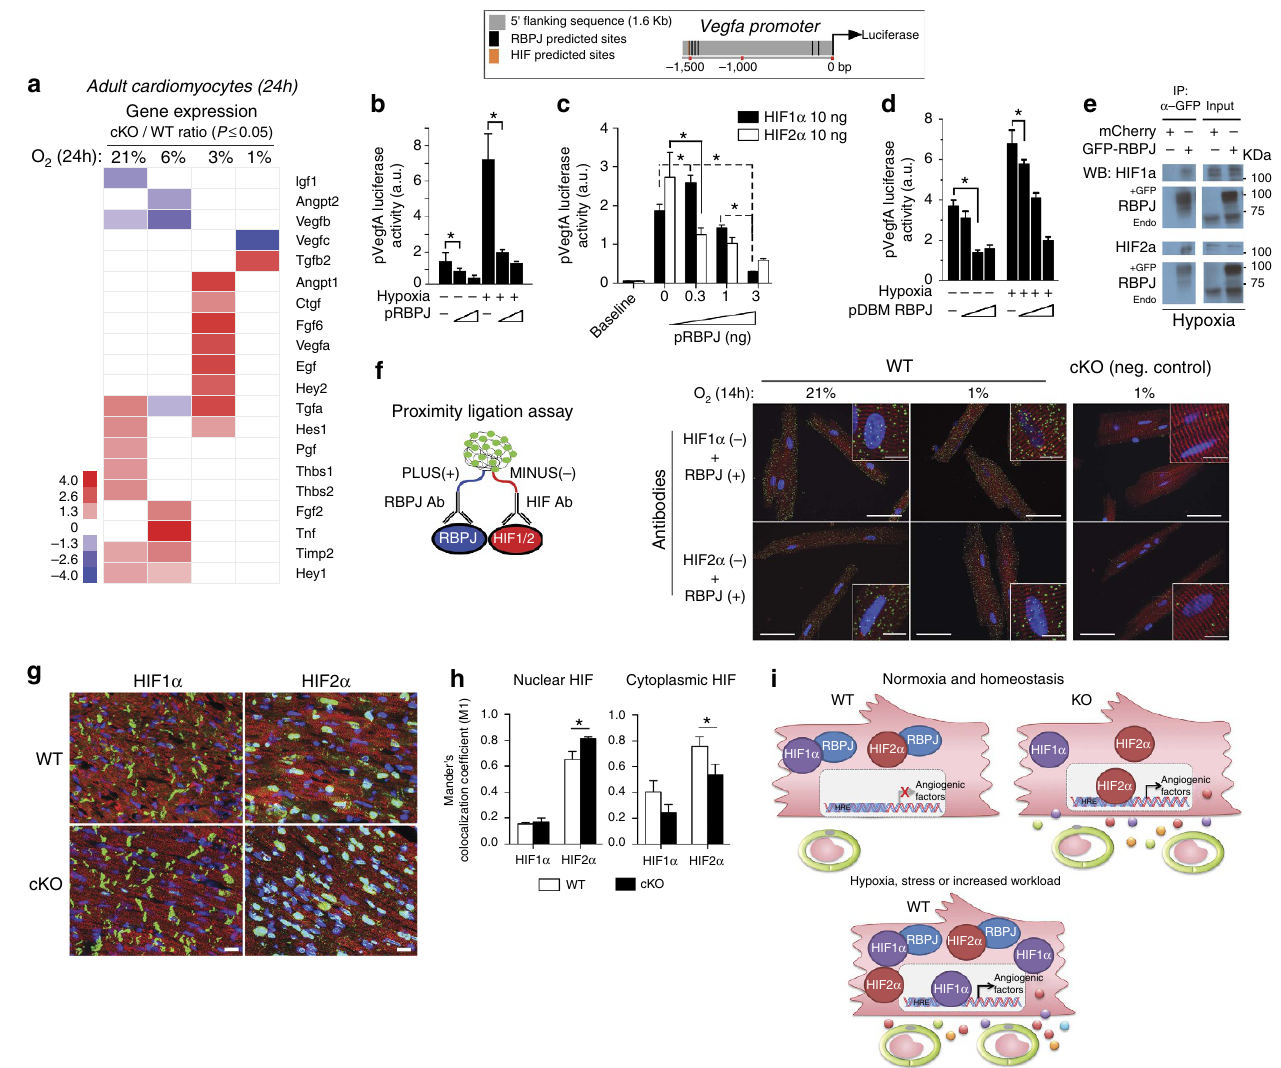
Figure 4 | RBPJ suppresses myocardial angiogenesis by antagonizing HIFs. ( a ) The heatmap represents the ratio of cKO to WT gene expression for statistically significantly induced (red) or repressed (blue) genes (Mann–Whitney, n ¼ 4, P r 0.05; see Methods section) in isolated cardiomyocytes cultured for 24h at the indicated O 2 levels. White indicates no differences. Inset to left shows colour scale. See Supplementary Fig. 7 for complete dataset. ( b – d ) Vegfa promoter (see inset) driving luciferase (50ng) was co-transfected with increasing amounts (1–5ng) of an RBPJ expression plasmid (pRBPJ) and is activity tested after 24h at baseline, hypoxia (1% O 2 ) ( b ) or upon activation by HIF1 a or HIF2 a expression plasmids (10ng) ( c ) in HEK 293T cells. Increasing concentrations of the DNA-binding mutant (DBM) of RBPJ, pDBM-RBPJ also inhibited Vegfa promoter basally and as induced by 24h of hypoxia (1% O 2 ) ( d ). n ¼ 3 on ( b ) and 5 on ( c , d ) biological replicates. ( e ) Co-IP of eGFP-tagged RBPJ with endogenous HIF-1 a and HIF-2 a under hypoxic (2% O 2 ) conditions. ( f ) Visualization of RBPJ interaction with HIF-1 a and HIF-2 a by in situ proximity ligation assay (PLA). Isolated ACM cultured for 14h under hypoxia (1% O 2 ) or normoxia (21% O 2 ) were incubated with RBPJ probe (conjugated with PLUS oligonucleotide) and HIF1 a or HIF2 a probes (conjugated with MINUS oligonucleotide). Positive interactions in WT cardiomyocytes (green fluorescence) are seen in the cytoplasm ( a (cid:2) actinin þ , red) and nuclei (DAPI, blue). cKO ACM were used as a negative control to show PLA signal specificity. Pictures are representative of at least three experiments. Scale bars, 50 m m, insets 10 m m. ( g , h ) HIF-1 a and HIF-2 a detected (both in green) in cKO and WT heart sections, co-stained with a -actinin (red) and DAPI (blue) ( g ). Manders co-localization coefficient M1 for HIF1 a or HIF2 a within nuclei (DAPI) (left graph, h ) or cytoplasm ( a -actinin þ ). For M2 of DAPI and a -actinin within HIF1 a and HIF2 a , see Supplementary Fig. 9). n ¼ 3 and 4 hearts for WT and cKO mice. Scale bar, 20 m m. ( i ) Paracrine regulation of myocardial angiogenesis. RBPJ antagonizes HIFs to homeostatically repress angiogenesis. HIF stabilization in response to decreased O 2 increases angiogenesis. All data are means ± SEM. * P o 0.05; ns, not significant; n , biological For histochemistry, hearts were fixed in 4% formaldehyde and processed for For frozen sections, tissue was fresh frozen in OCT. Histological sections were paraffin embedding. Sections were stained for Massons’ trichrome (collagen stain), fixed in methanol/acetone (1:1) at (cid:2) 20 (cid:2) C for 2min and processed as described PAS (periodic acid acid-Schiff) (to detect glycogen) and Oil red-O (to detect lipid) above, but the antigen retrieval step was omitted. Frozen sections were incubated following standard procedures (Sanford-Burnham-Prebys Histology Core Facility). with goat anti-fibrin/fibrinogen (GAM/Fbg/Bio; Nordic Immunology) (1:500), rat Sections were mounted and photographed on a TE300 Nikon microscope with anti-mouse CD31 (BD-Pharmingen) (1:100), anti-alpha smooth muscle actin 40 (cid:3) (N.A. 0.75) objective. (Sigma) (1:500) primary antibodies and alexa fluor-conjugated (488 or 586) For plastic casting of coronary vascular trees, Microfil polymer (Flow Tech, streptavidin or goat anti-rat or goat anti-mouse IgG (all 1:500). Biotin blocking was Inc.) was perfused through the aorta of isolated hearts 2 . Mice had been previously performed as described for the Streptavidin/Biotin blocking kit (Vector Labs) on those sections incubated with biotin-conjugated antibodies. injected with heparin and the heart washed with saline solution to remove blood.